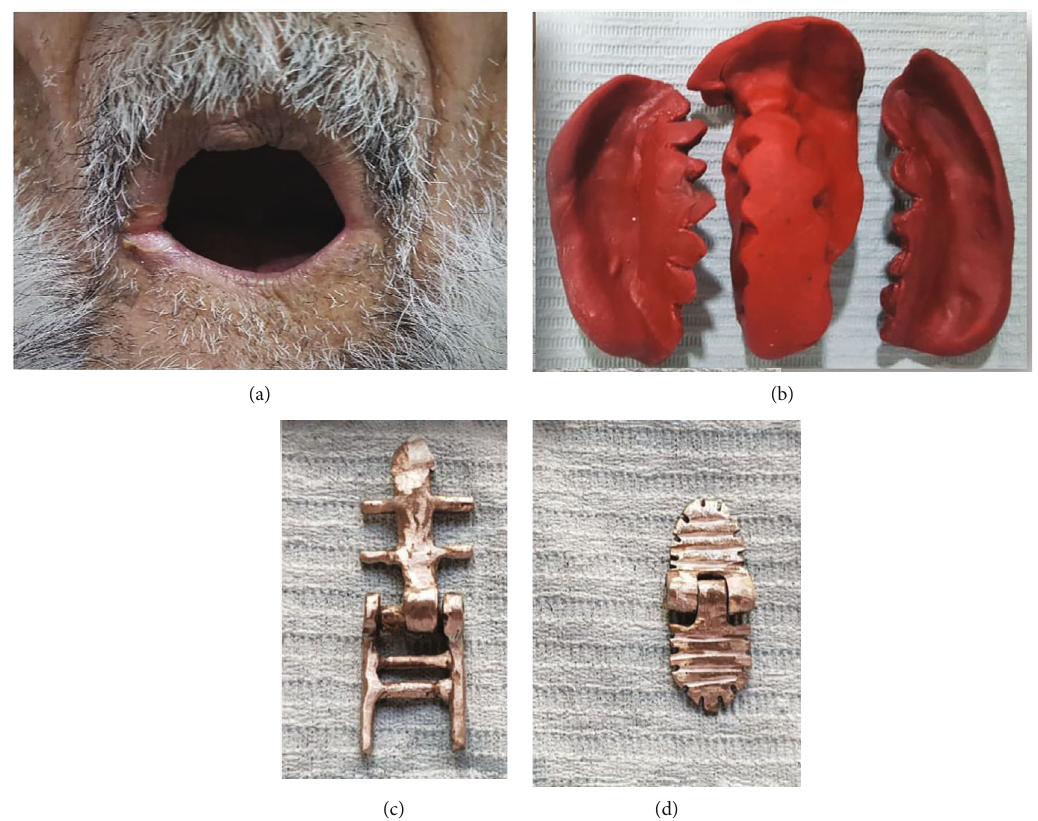
Figure 1: (a) Reduced oral access, 20mm height and 32 mm intercommissural width. (b) Maxillary sectional primary impression. (c) Maxillary custom-made hinge. (d) Mandibular custom-made